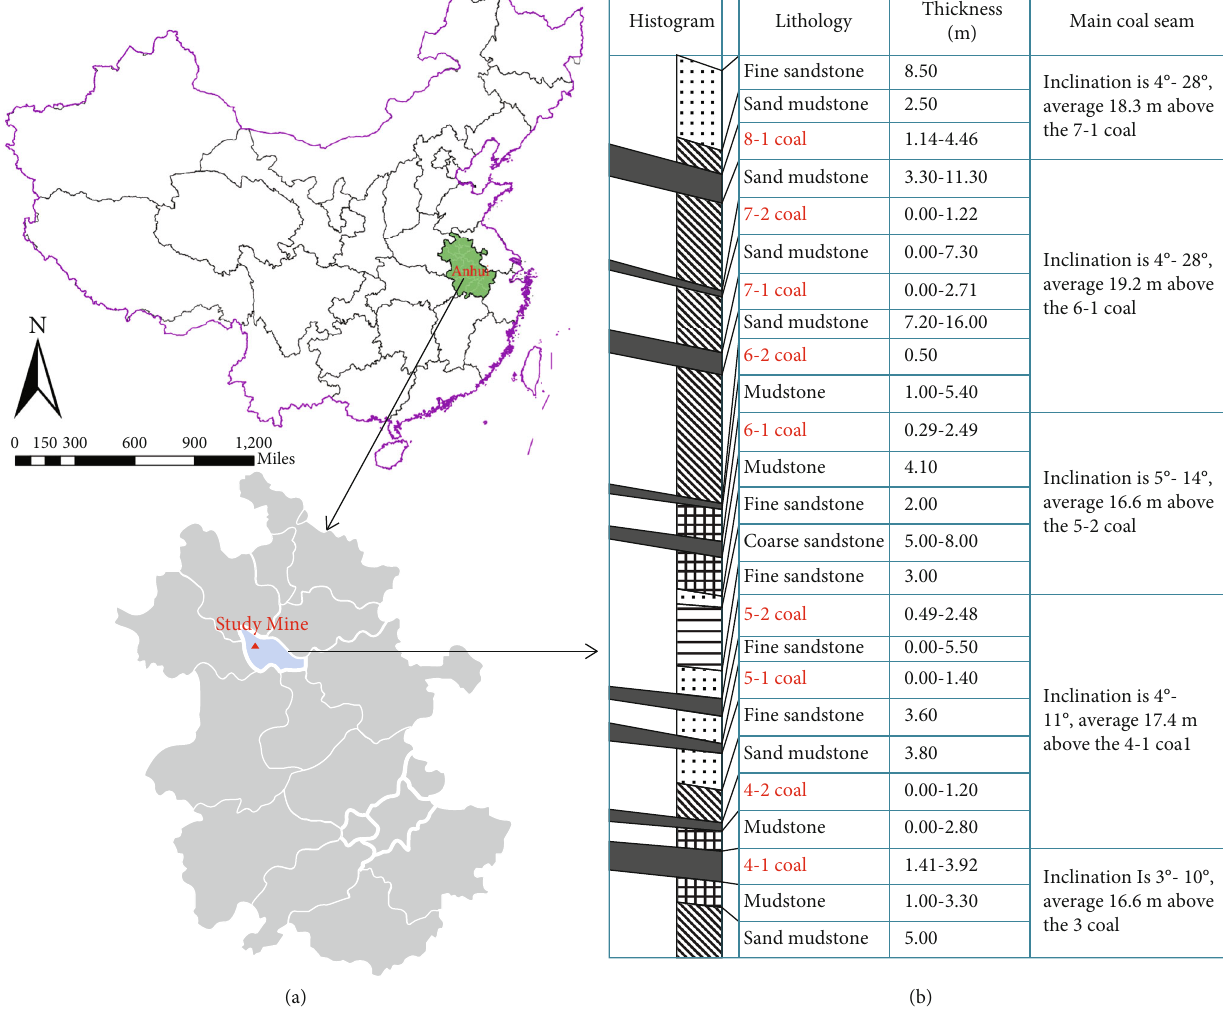
Figure 1: The Pan ’ er Coal Mine location (a) and comprehensive stratigraphic column